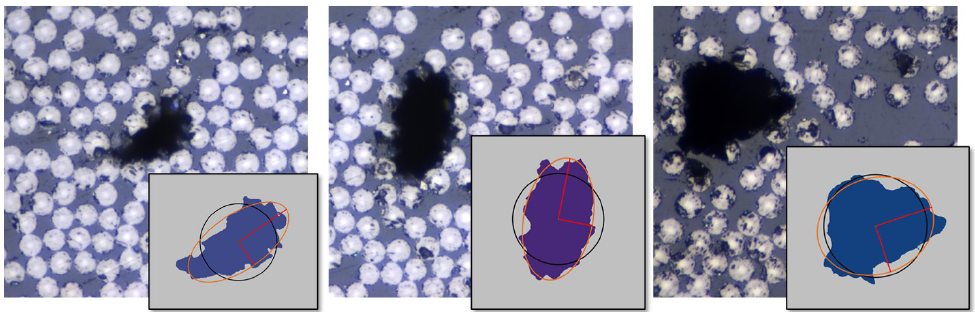
Figure 6. Comparing true voids from micrographs to a circular and an elliptical